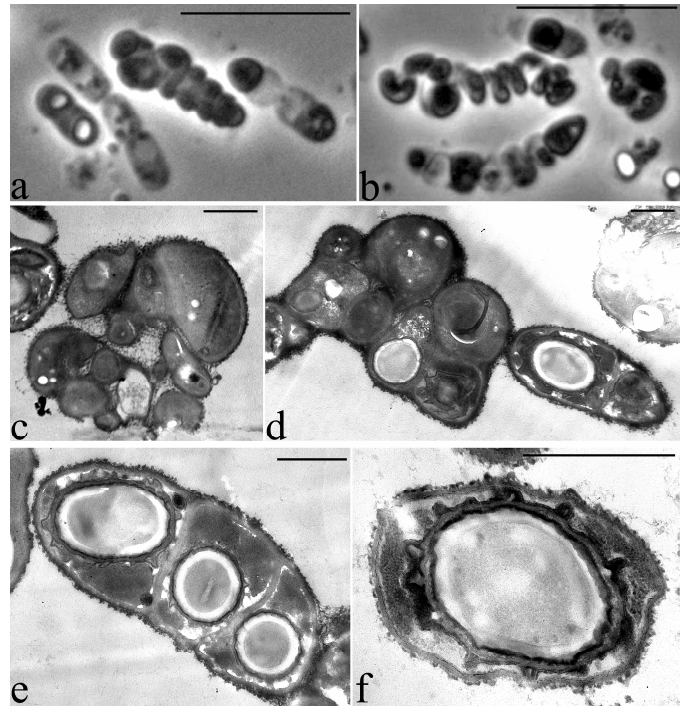
Figure 9. Phase contrast ( a , b ) and ultrathin sections ( c – f ) of the cleaving cells of Priestia aryabhattai strain 25 in a conglomerate (bunch). Some cells in the conglomerate are ultra-small (less than 300 nm in diameter). Light microscopy. Phase contrast. Bar—10 µm. Transmission Electron Microscopy. Bar—1 µm.